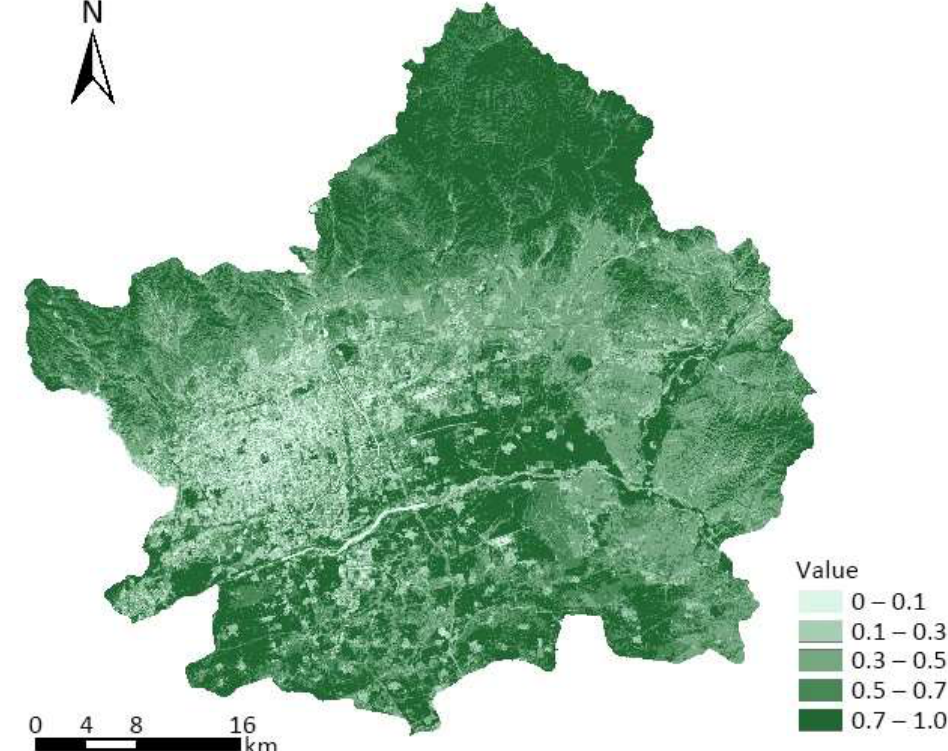
Figure 3. Vegetation coverage (VC) grading of the urban area of Hohhot in 2018.